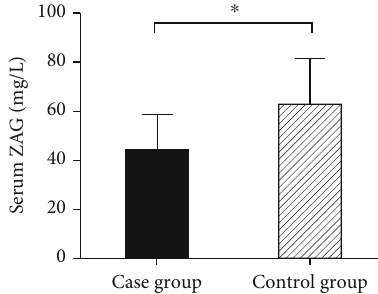
Figure 1: Comparison of serum ZAG between the two groups.